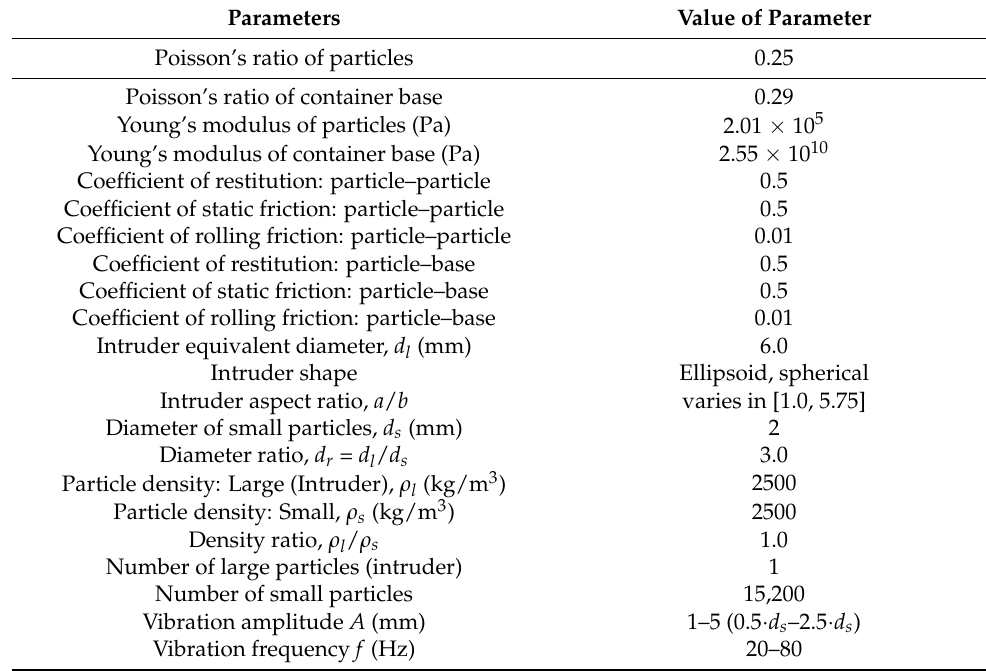
Table 2. List of parameters used in the simulations.